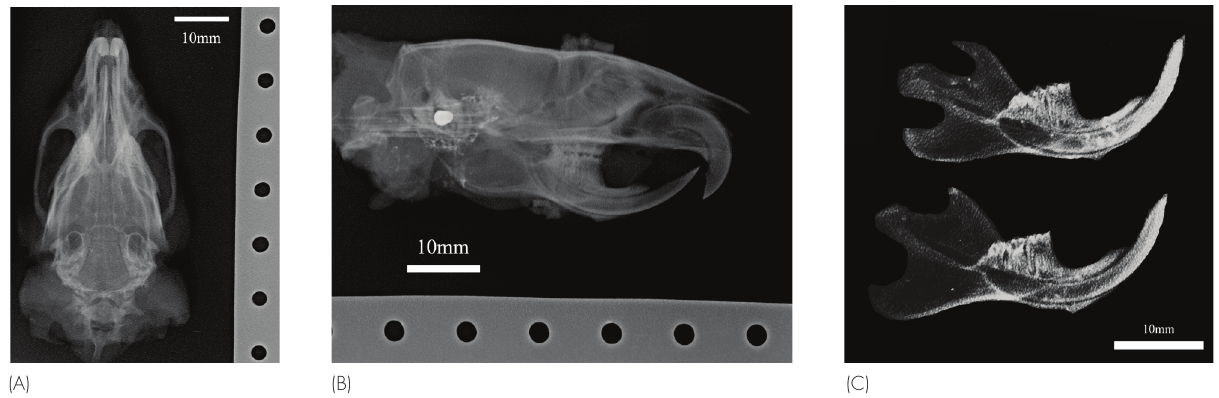
Figure 1. Examples of radiographs of rat skulls: (A) Submento-vertex view. (B) Lateral cephalometric view. (C) Hemi-mandibular view. Note on the hemi- mandibular view: the difference between the experimental side hemi-mandibles from a denervated animal (upper) and a β 2-agonist only animal